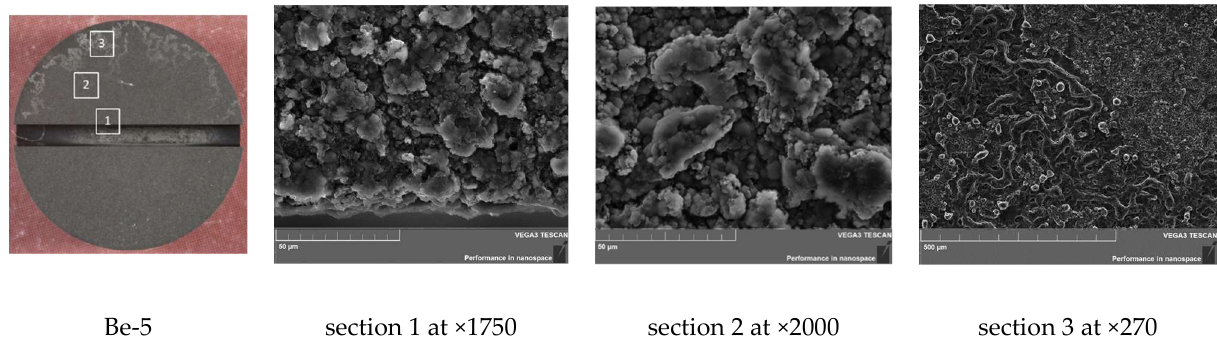
Figure 11. SEM images of the Be-5 sample surface (800 °С, 100 cycles).